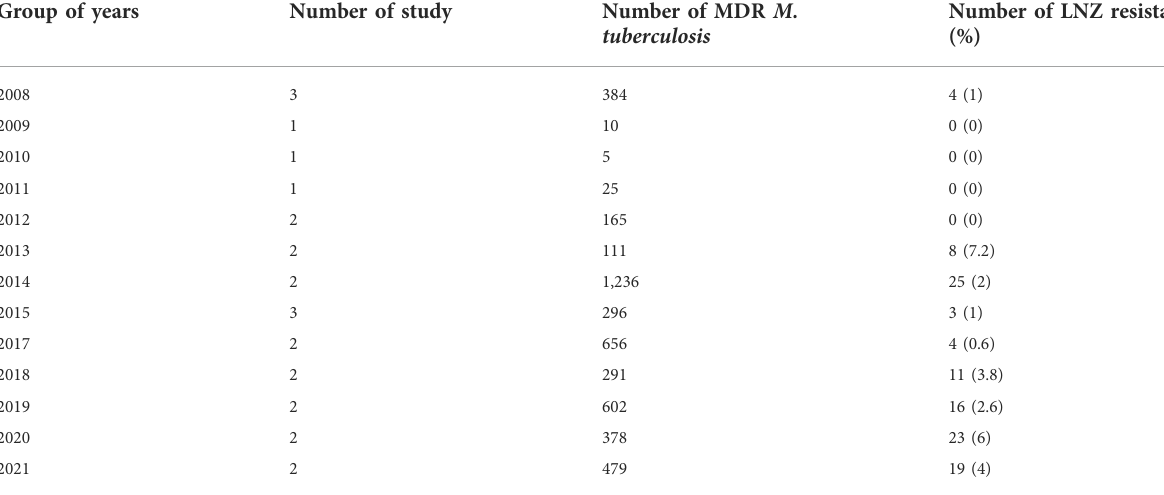
TABLE 3 Time trend analysis of linezolid resistance in MDR M. tuberculosis Group of years Number of study